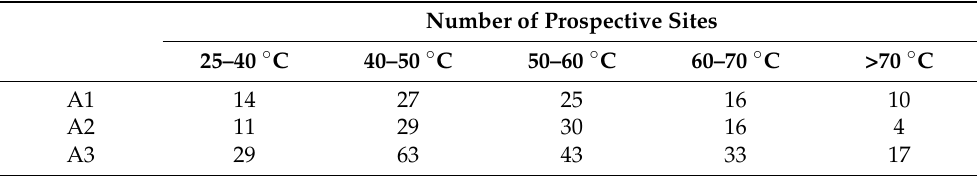
Table 4. Distribution of the number of prospective sites in each temperature